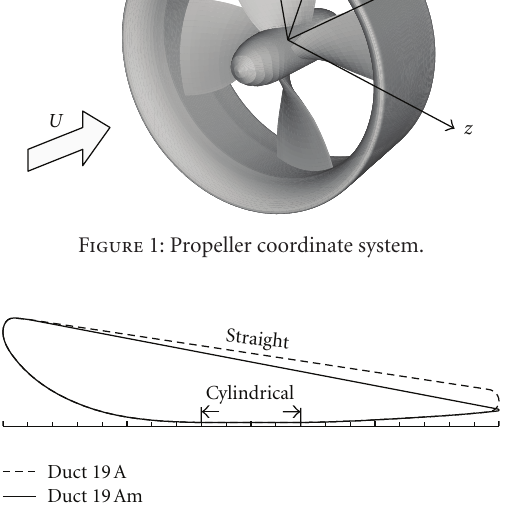
Figure 2: Profiles of duct 19A and 19Am. Figure 3: Experimental open-water characteristics of propeller Ka4-70 in duct 19A and duct 19Am.